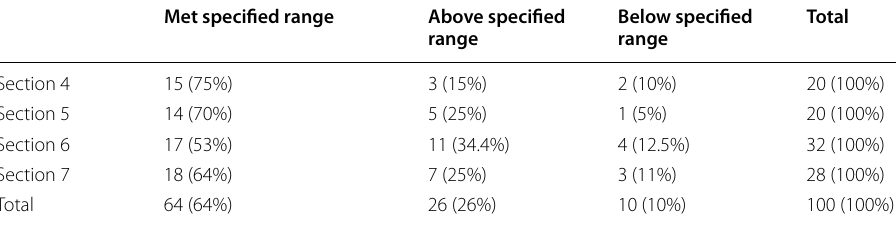
Table 3 The extent to which the 100 items meet the specified difficulty range (based on p -value and organized according to the test